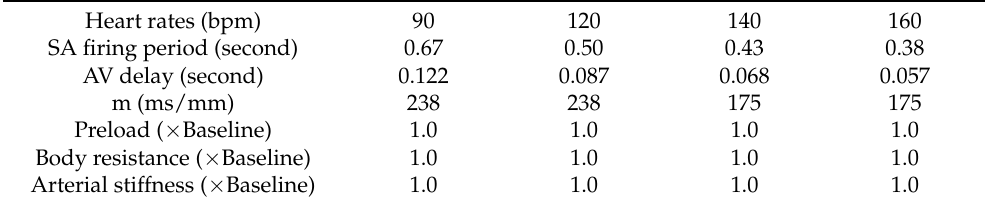
Table 3. Adjustment to LHHM model inputs to study increased heart rate during